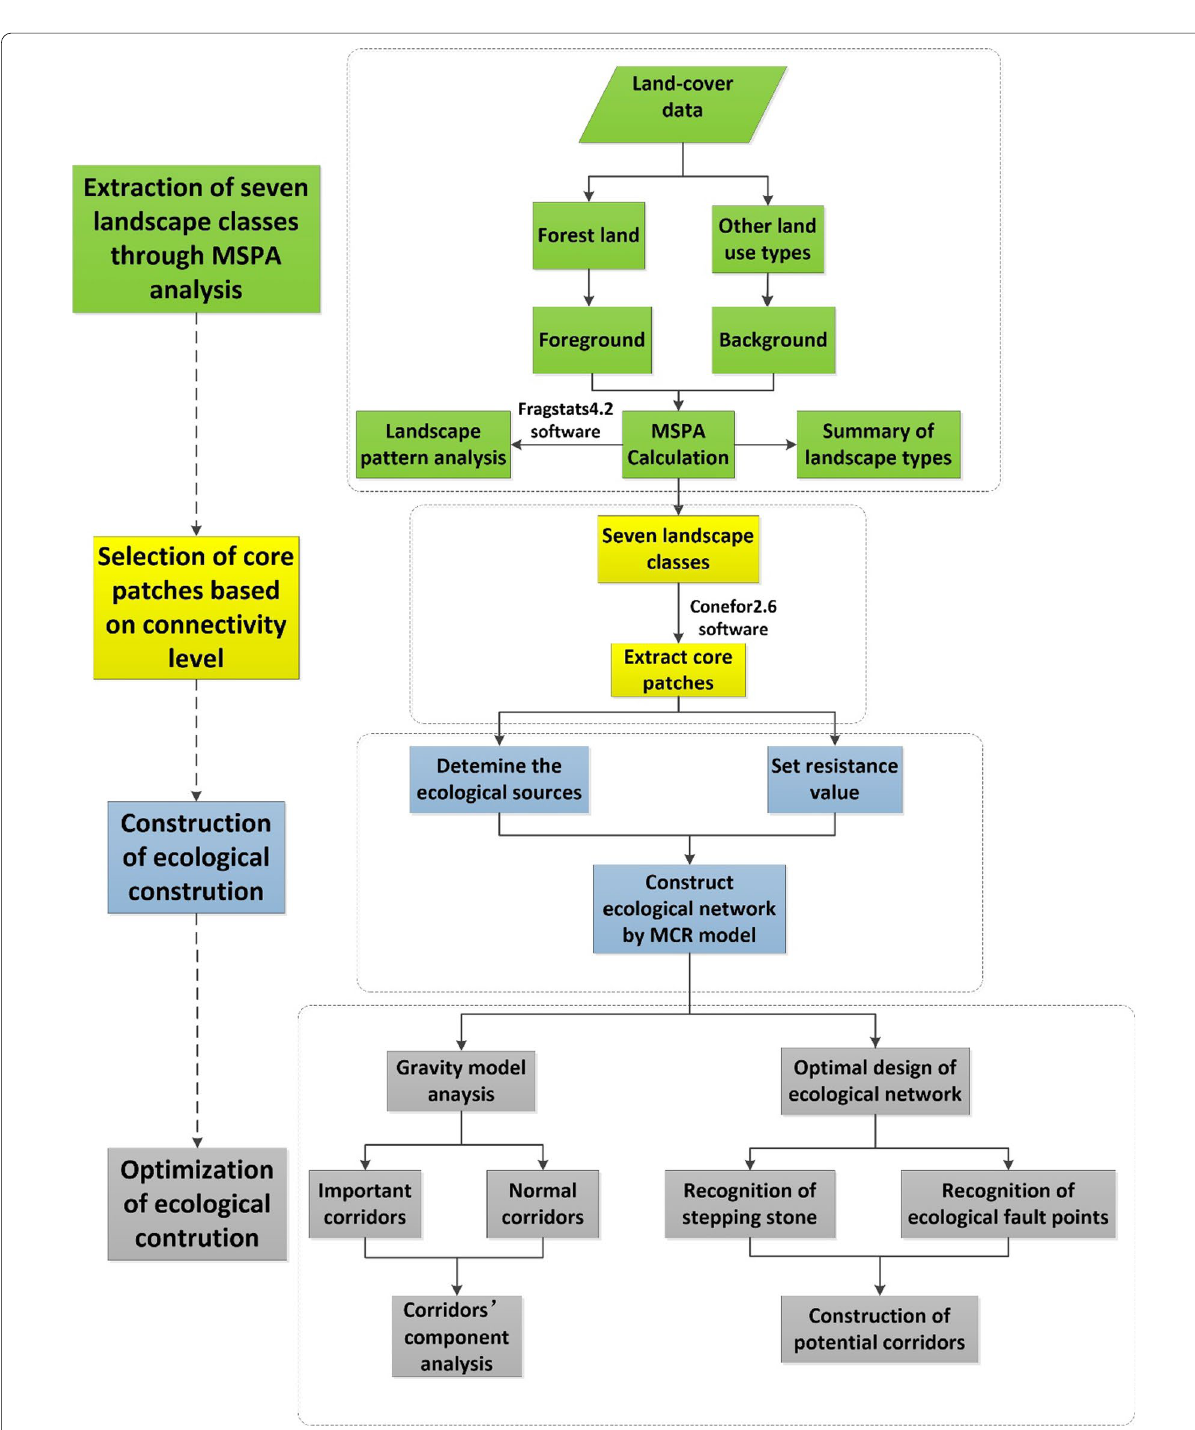
Fig. 2 Flow diagram describing the workflow for constructing and optimizing ecological networks in Shenzhen City. MSPA morphological spatial pattern analysis, MCR minimal cumulative